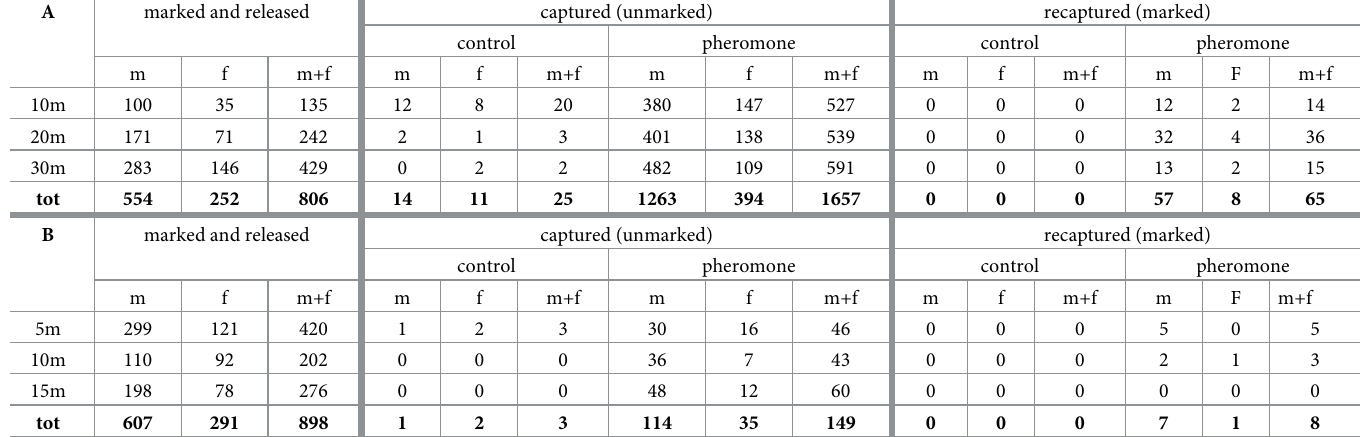
Table 2. Summary of numbers of Lu . longipalpis sand flies captured and recaptured at the two household sites (A and B) in Governador Valadares (Minas Gerais,